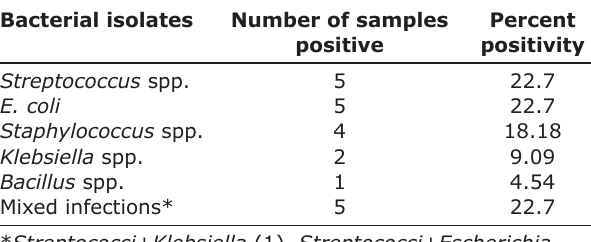
Table-1: Relative frequency of organism isolated from urine samples of dogs suffering from urinary tract infections. Bacterial isolates Number of samples